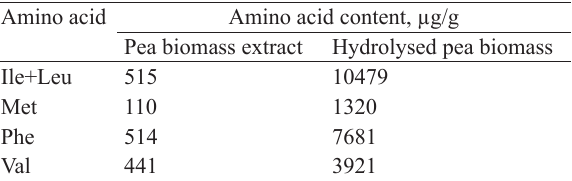
Figure 7 Scanning electron microscopy of the hydrolysate after spray-drying